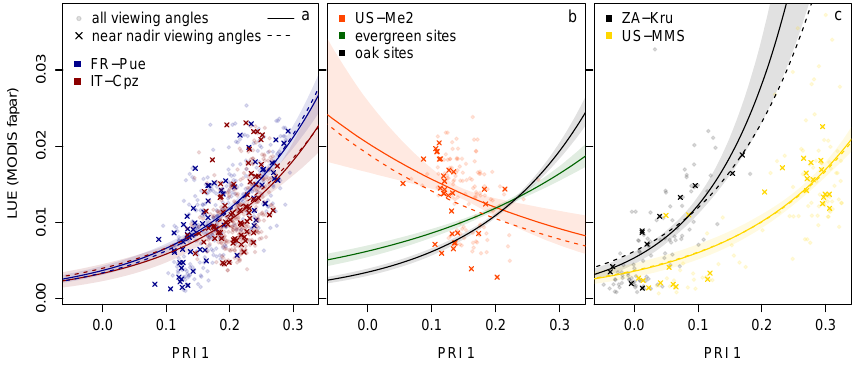
Fig. 2. Light use efficiency (based on MODIS faPAR) versus PRI based on reference band 1 with exponential models fitted to the observa- tions. The shaded areas represent the 95% Bayesian confidence interval. For each site, two different models were calculated. One is using all available observations (solid lines) and the other only observations with near nadir sensor viewing angles (0–10 ◦ , dashed lines). In addition, the combined models for evergreen sites (FR-Pue, IT-Cpz, US-Me2) and oak sites (FR-Pue, IT-Cpz) are shown (panel c).